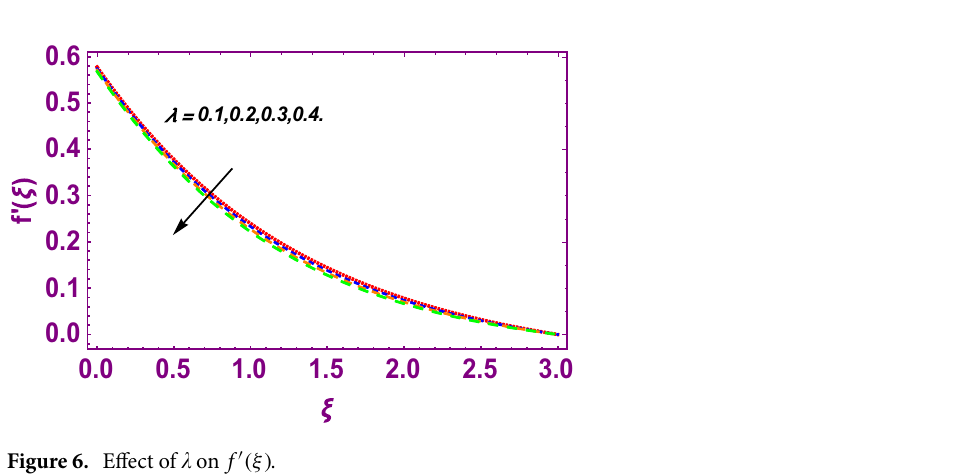
Figure 6. Effect of (cid:31) on f ′ (ξ)